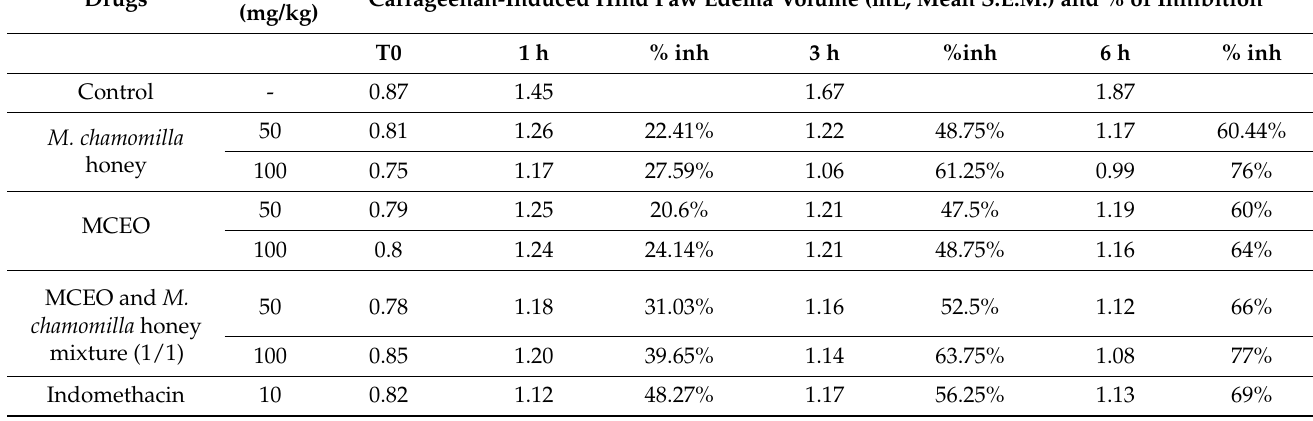
Table 5. In vivo anti-inflammatory activity. Inhibition percentage of the left hind paw volume in rats treated with MCEO, M. chamomilla honey, and their